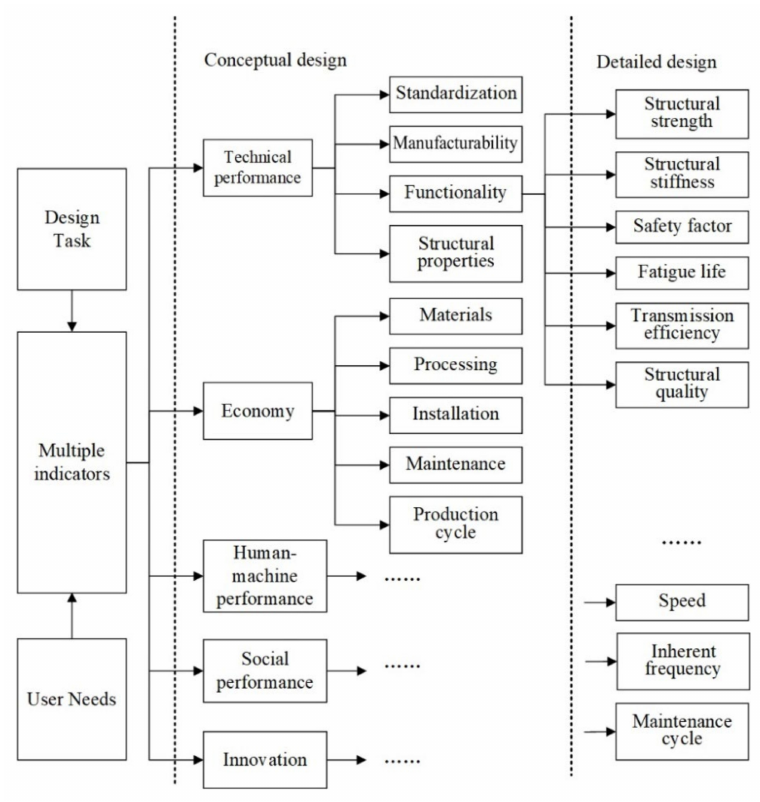
Figure 2. The indicators of the decision